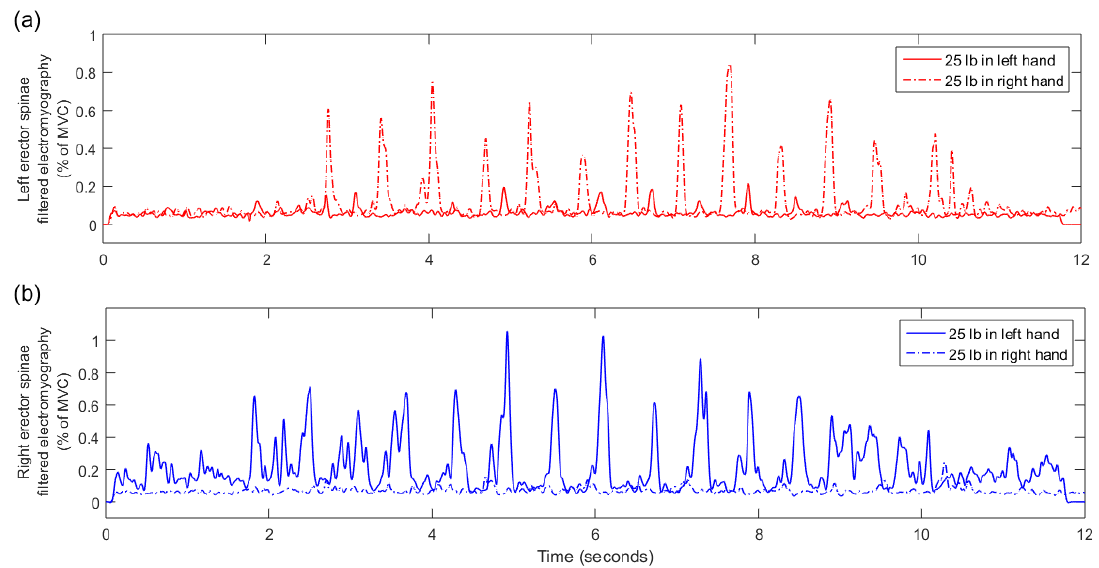
Figure 2. An example of one participant’s rectified and bandpass-filtered electromyograms of the left ( a ) and right ( b ) erector spinae muscle for asymmetric (unilateral) dumbbell carrying. The full line shows muscle activity for a trial where the participant carried a 25-lb dumbbell in their left hand while the dotted line shows muscle activity for a trial with a 25-lb dumbbell in their right hand. A common, though subjectively observed, pattern was that the left muscle ( a ) exhibited higher electromyogram values when a dumbbell was held in the right hand, and vice versa. MVC—peak value obtained during maximum voluntary contraction.